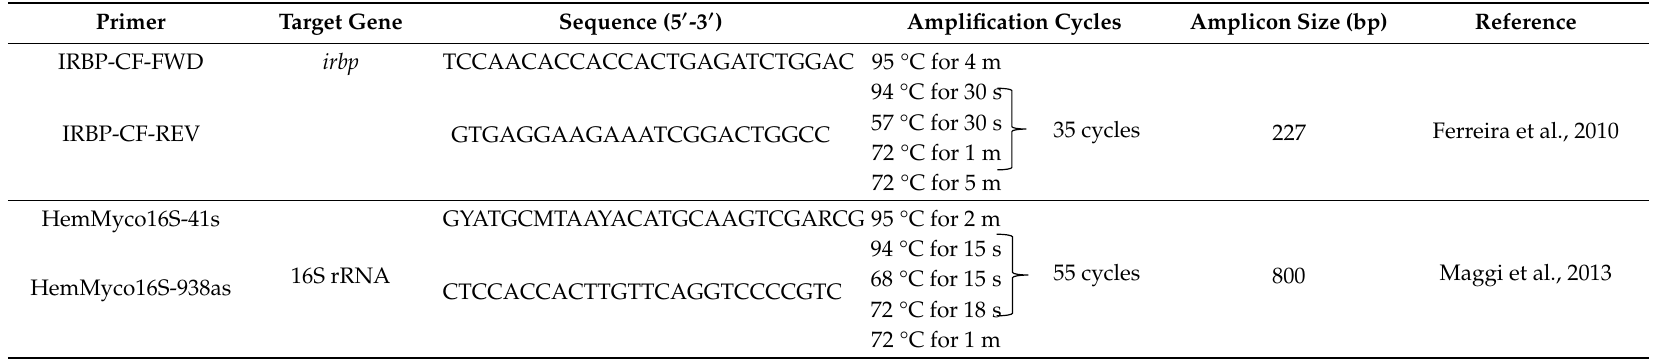
Table 1. Summarized information on the different primer sets, amplification cycles, and product size used in conventional PCR assays.